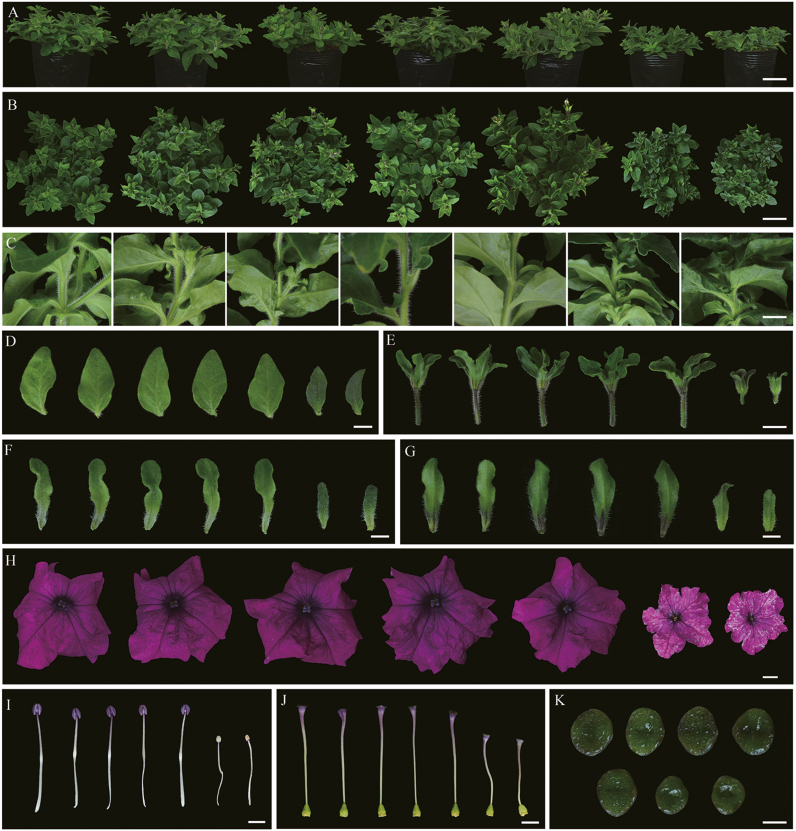
Phenotypic alterations caused by VIGS-mediated silencing of PaACLAs and PaACLBs in petunia plants. (A–G) Left to right: 5-week-old pTRV2-treated (control) and PaACLA1-, PaACLA2-, PaACLB1-, PaACLB2-, PaACLA1-A2-, and PaACLB1-B2-silenced plants: side view (A), top view (B), stems (C), leaves (D), pedicels (E), abaxial surface of sepals (F), and adaxial surface of sepals (H). (H) Left to right: flowers of the control and PaACLA1-, PaACLA2-, PaACLB1-, PaACLB2-, PaACLA1-A2-, and PaACLB1-B2-silenced plants. (I–K) Left to right: control and PaACLA1-, PaACLA2-, PaACLB1-, PaACLB2-, PaACLA1-A2- and PaACLB1-B2-silenced stamens (I), pistils (J), and stigmas (K) from 5-week-old plants. Bars=4 cm in (A) and (B); 1 cm in (C), (E), and (H); 0.5 cm in (D), (F), (G), (I), and (J); 0.15 cm in (K).